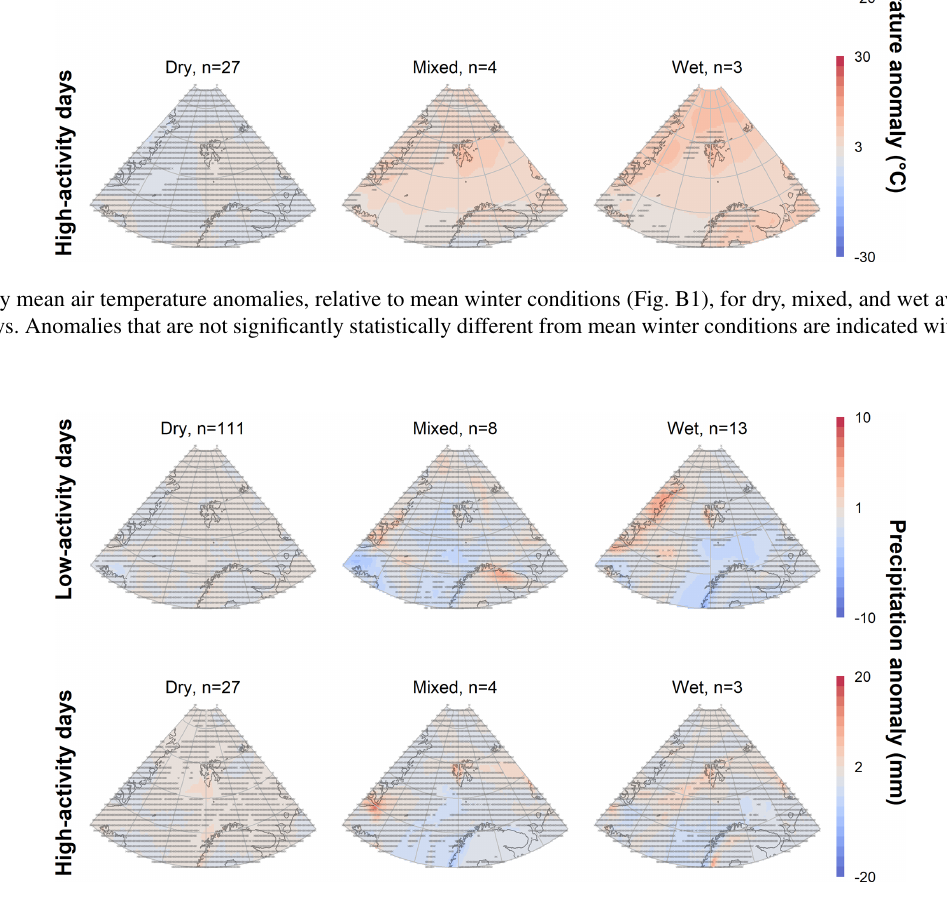
Figure C2. Daily accumulated precipitation anomalies, relative to mean winter conditions (Fig. B2), for dry, mixed, and wet low- and high-activity days. Anomalies that are not significantly statistically different from mean winter conditions are indicated with dense hatching.